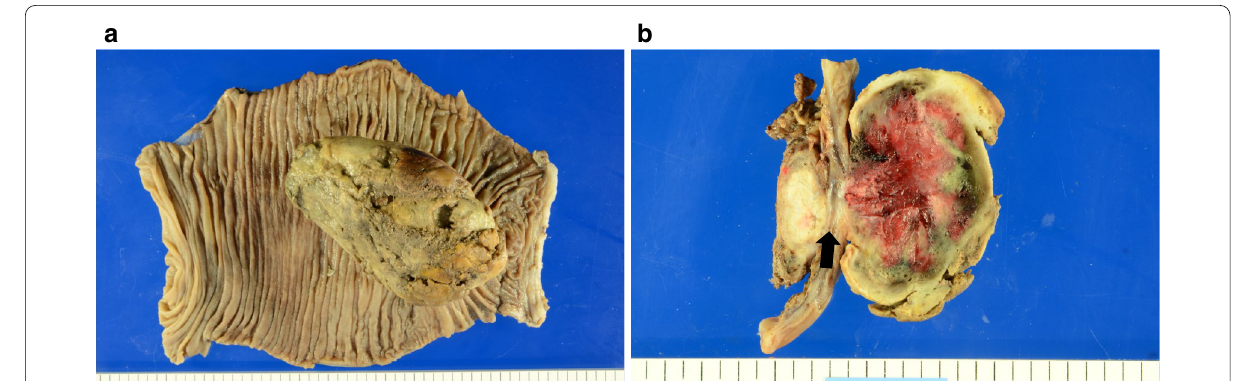
Fig. 4 Resected specimen. a Surgical specimen from the distal pancreatectomy and jejunal limb resection. The tumor, 11.8 was located in the jejunum. b Pancreatic metastasis of RCC had invaded the jejunal wall